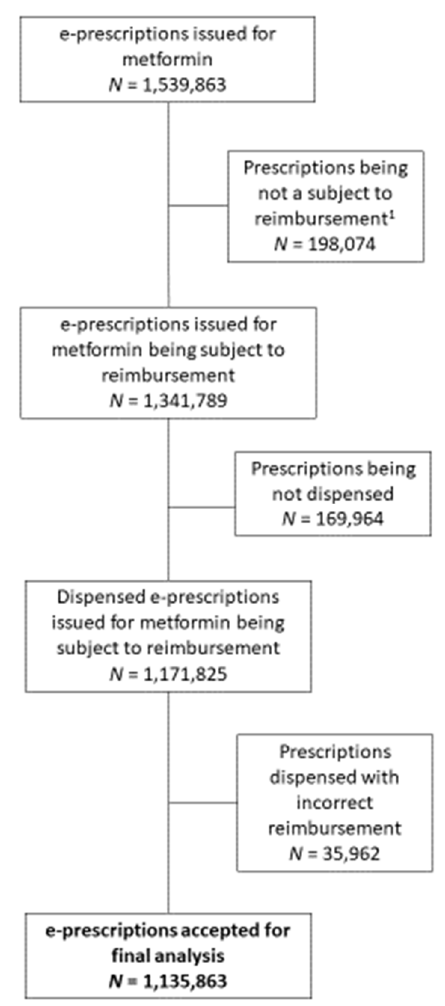
Figure 1. Flow chart presenting a selection of e-prescriptions issued for metformin in Poland in 2019 to be included in the final analysis; (1) e-prescriptions issued to citizens who did not benefit from reimbursement, e.g., those not covered by NHF insurance, foreigners, etc.